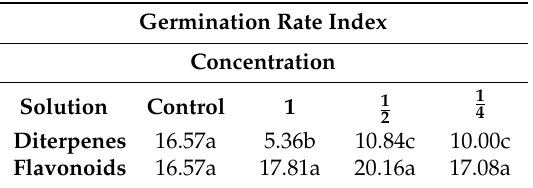
Table 2. Germination rate index of the seeds of C. ladanifer watered with solutions of diterpenes and flavonoids at different concentrations (6 replicates per treatment): 1 (0.26 g/L), 1 and 1 (0.065 g/L). Different letters indicate significant differences between different concentrations 4 (M-W; p < 0.05).